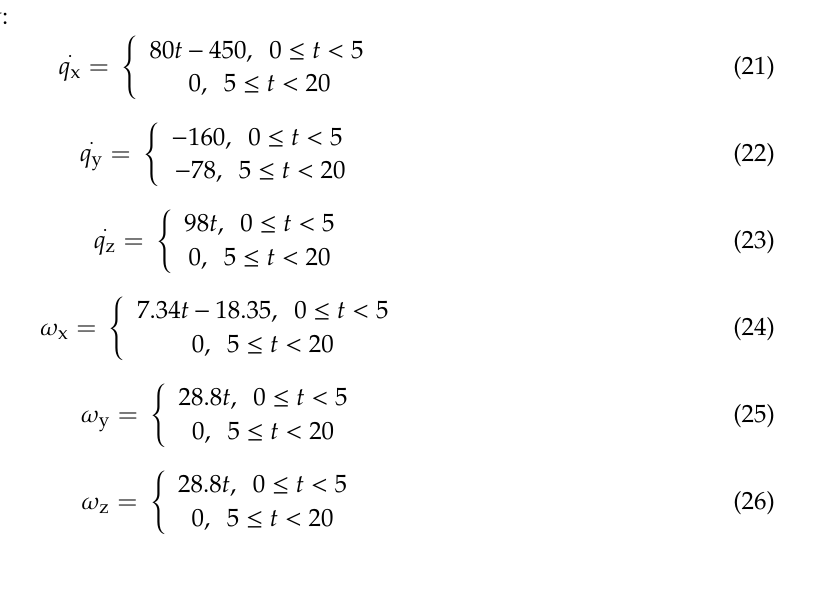
Figure 16. The joint angles of the climbing mechanism.